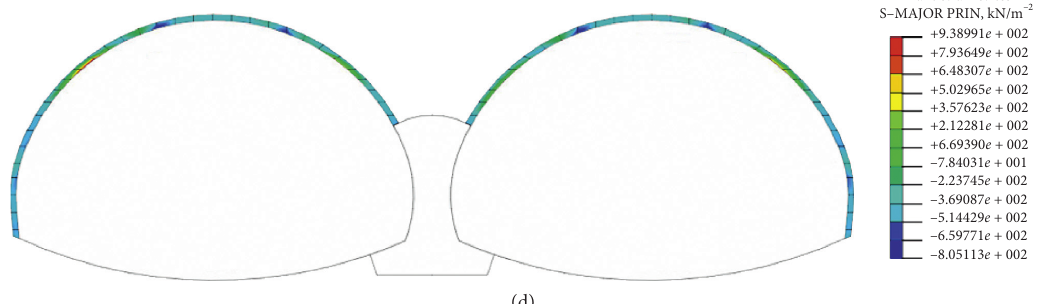
Figure 10: Maximum principal stress of the secondary liner in the double-arch tunnel. (a) Plan 1. (b) Plan 2. (c) Plan 3. (d) Plan 4.